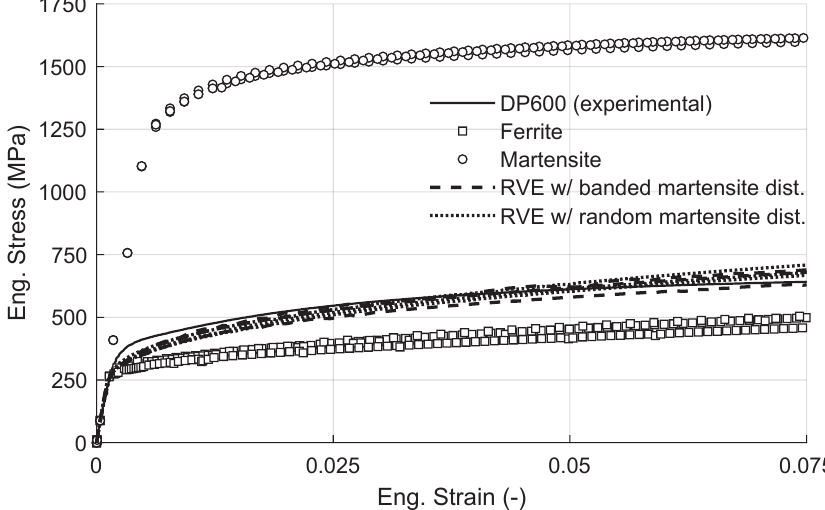
Figure 5. Stress–strain response of DP600 (experimental), individual phases and the different